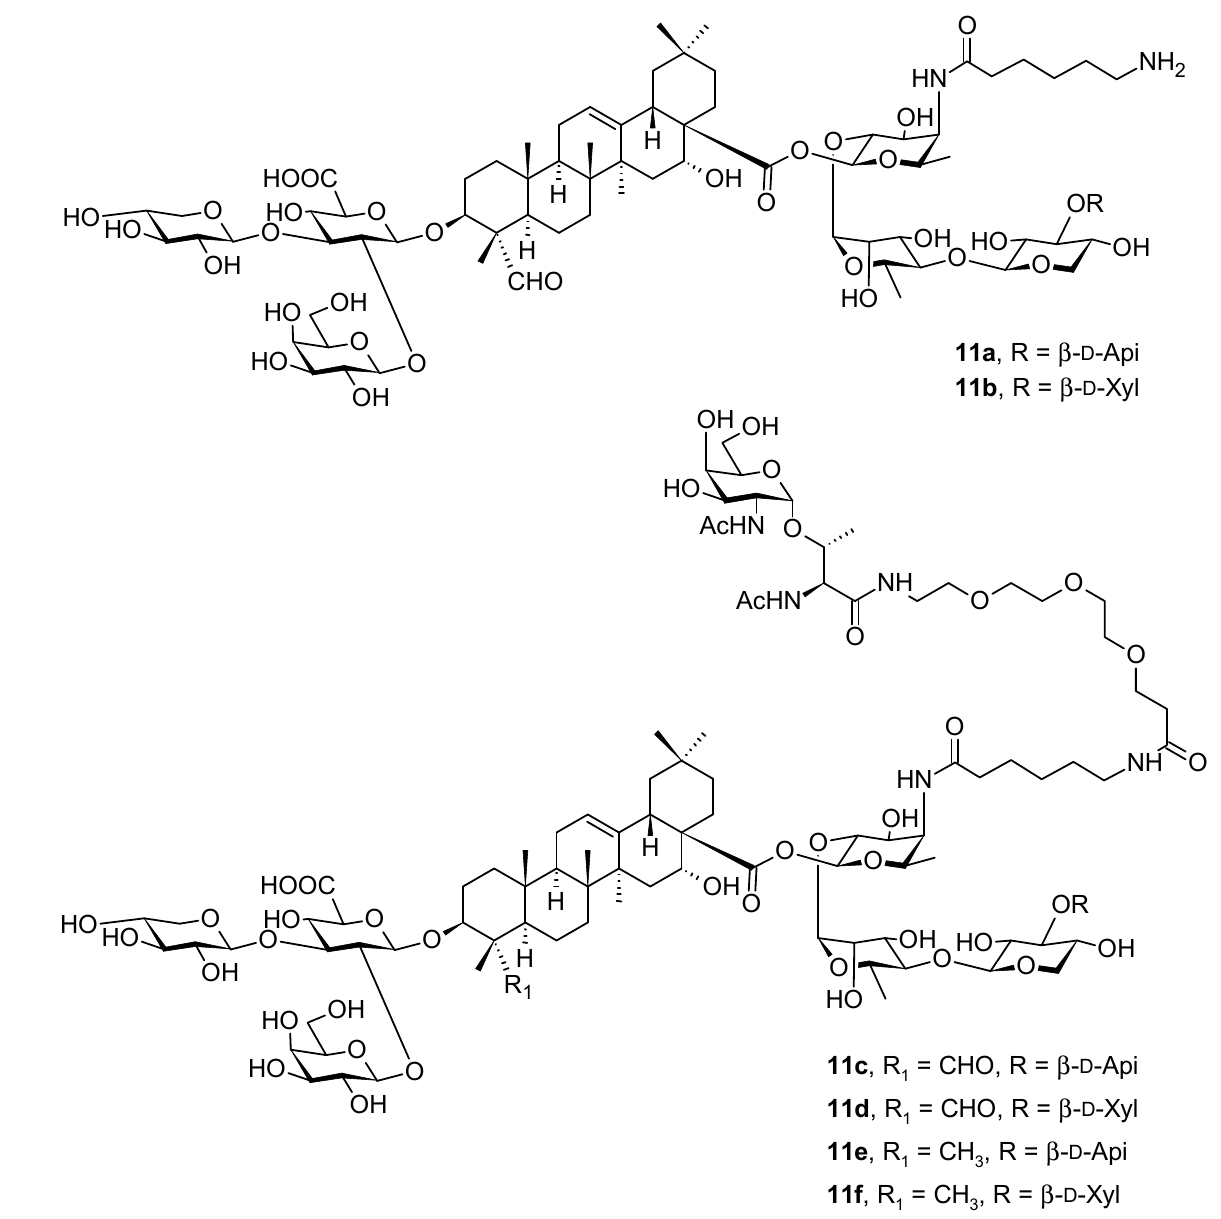
Figure 11. Oleanane-type saponin adjuvants.